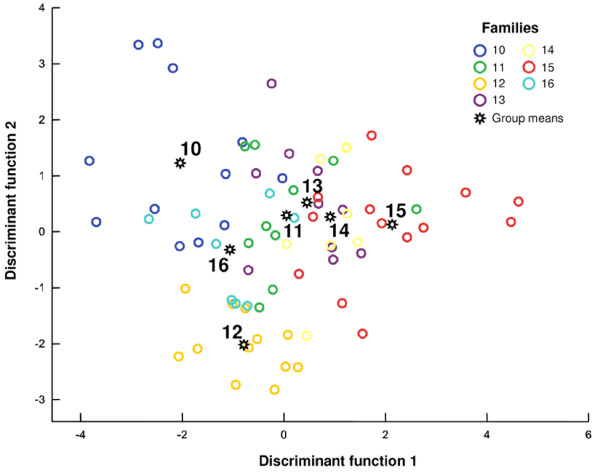
Discriminant analysis of the variation of the sex-pheromone on the family level. Despite some overlap, the families are significantly separated (data set 1, one population: Würzburg City, C25-type only; see Table 1 and text for details).